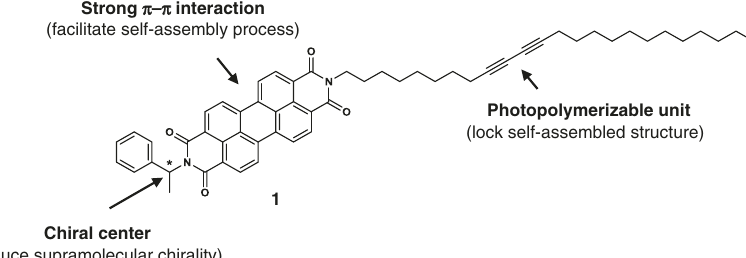
Fig. 1 Molecular design. Molecular structure of diacetylene-containing chiral perylene diimide (PDI) 1 and roles played by the functional elements.